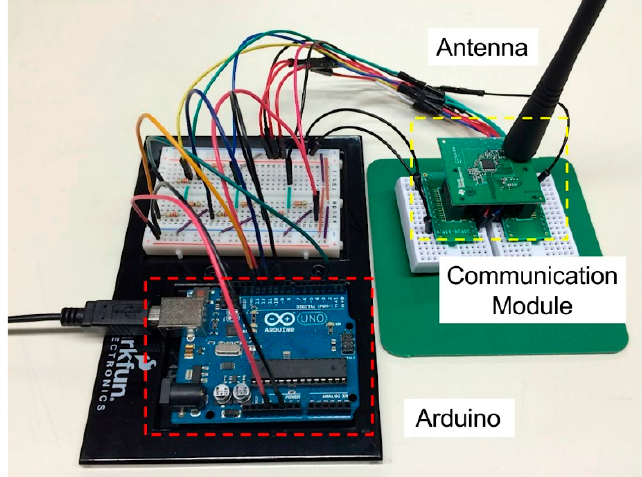
Figure 4. Fabricated wireless communication system.